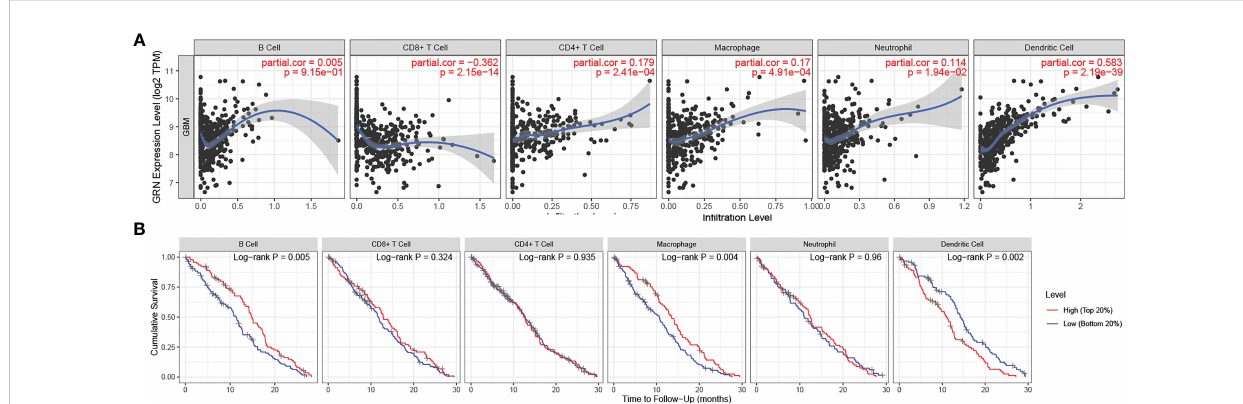
FIGURE 5 (A) GRN expression level has signi fi cant positive correlations with in fi ltrating levels of B cell, CD4+ T cells, Macrophages, Neutrophils and DCs in GBM. (A positive correlation exists between the GRN expression level and in fi ltrating levels of B cell(r = 0.005, P = 9.15e-01), CD4+ T cells (r = 0.179, P = 2.41e-04), Macrophages (r = 0.17, P = 4.91e-04), Neutrophils (r = 0.114, P = 1.94e-02), and DCs (r = 0.583, P = 2.19e-39) in GBM) (B) cumulative survival is related to B cell, Macrophages and DCs in GBM. (The B cell, Macrophages and DCs are factors related to the cumulative survival rate of GBM over